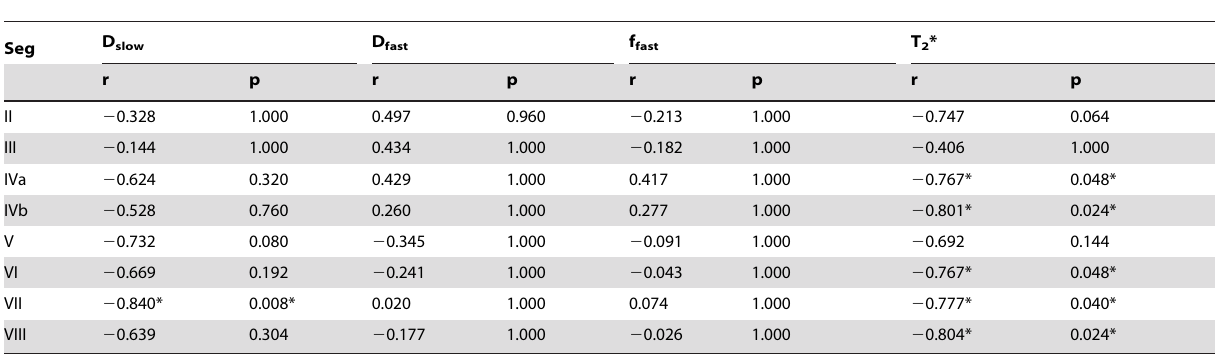
Table 4. Correlations with hepatic fat fraction (HFF) per segment.